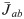
System identification of the SSN model from simulated tuning curve data using the cWGAN method and moment matching methods.Top and bottom rows show the results of cWGAN and moment matching fits, respectively. (A) & (D): symmetric mean average percent error (sMAPE), Eq (44), of all parameters throughout training. (B) & (E): the J¯ab (solid lines) and δJab (shaded areas) parameters throughout training. The box to the right shows the true parameters as points (J¯ab) with error bars (δJab). (C) & (F): σab throughout training. Arrows to the right of the plot denote the true values of σab; note that the E → I and I → I arrows occlude each other in panels C and F. In B-C and E-F colors represent connection-types as shown in the legend of B. The input heterogeneity parameter V (not plotted) converged to 0.100 for cWGAN, and to 0.116 for moment matching, compared to the value V = 0.1.